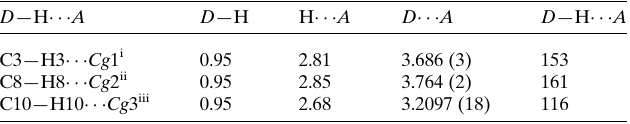
Table 1 Hydrogen-bond geometry (A˚ , (cid:2) ).